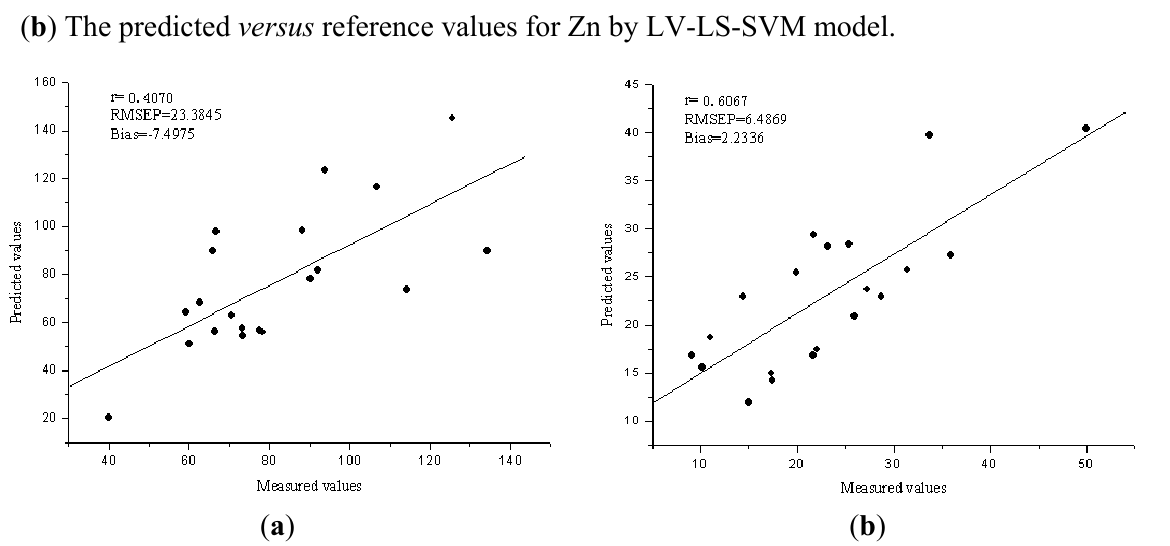
Figure 4. ( a ) The four ICs for Fe by the ICA-LS-SVM model. ( b ) The four ICs for Zn by the ICA-LS-SVM